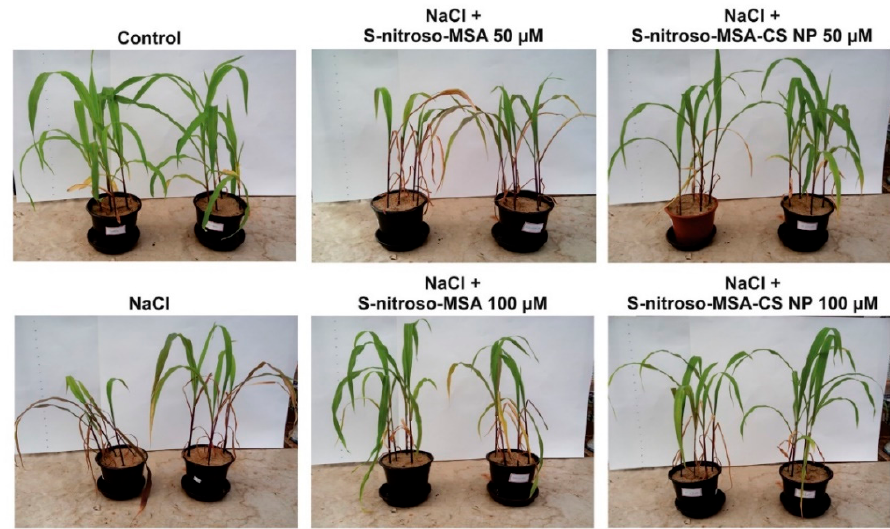
Figure 3. Comparison of maize plants under salt stress treated with free S-nitroso-mercaptosuccinic acid (MSA) to the plants treated with chitosan nanoparticles encapsulating S-nitroso-MSA at 50 or 100 µ M concentration. It shows that the treatment with S-nitroso-MSA-Chitosan nanoparticles at both concentrations was e ff ective in relieving the visible e ff ects (necrosis) of salt stress in the plants compared to free S-nitroso-MSA, which has shown to be e ff ective only at 100 µ M concentration. Control plants were treated only with distilled water or salt without any treatment. Reproduced with permission from Reference [51] Copyright © 2016 Elsevier.